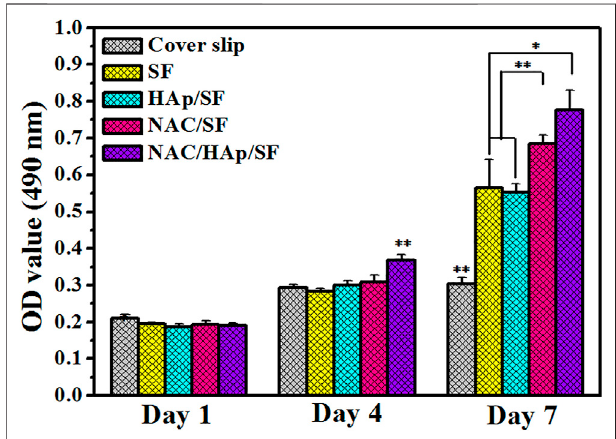
FIGURE 5 | Proliferation of iPSC-MSCs on different composite fi bers and cover slip, n (cid:1)